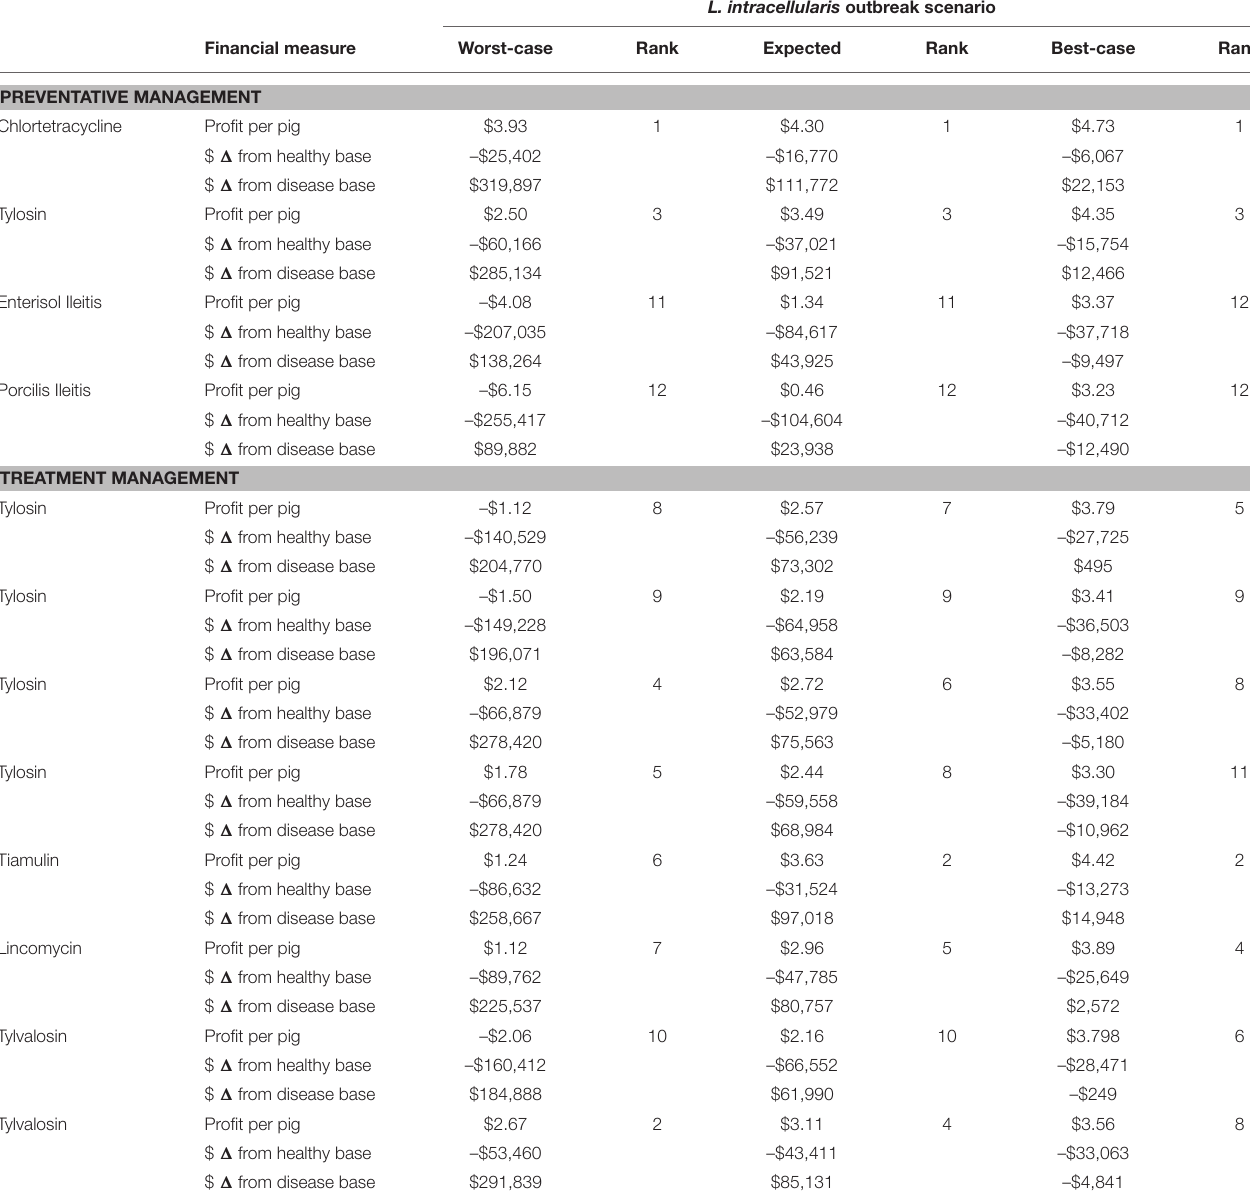
TABLE 7 | Cost-effectiveness and ranking of management options for L. intracellularis